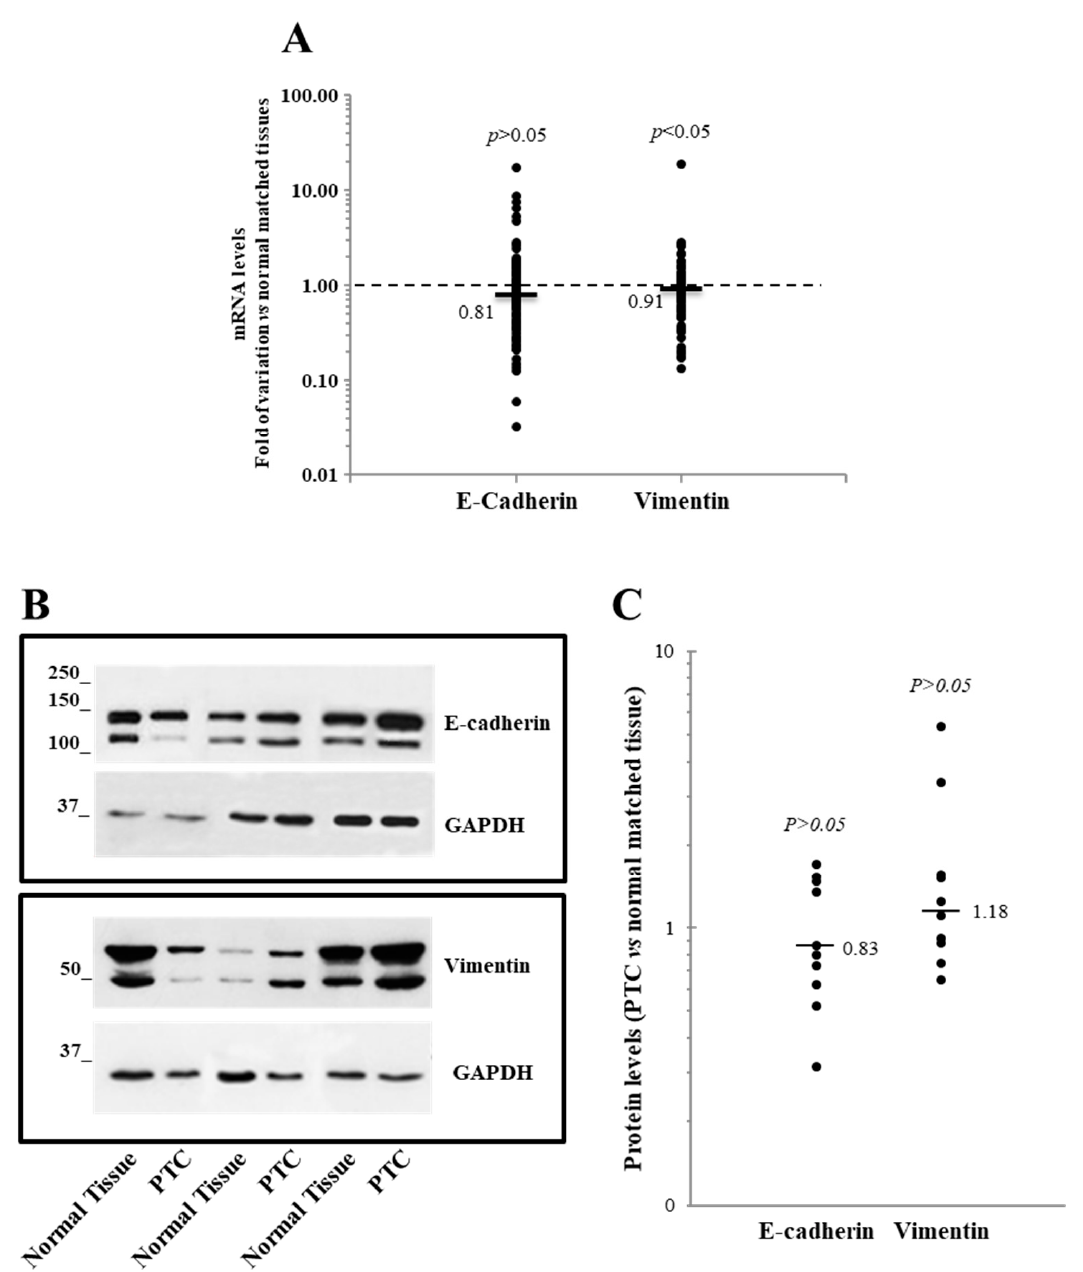
Figure 2. Expression level of the E-cadherin and vimentin in 95 papillary thyroid cancer (PTC) tissues compared with the normal matched tissues. ( A ) The E-cadherin and vimentin mRNA levels are reported. The small bars represent the median, with the values indicated. The dotted line represents the expression levels for the normal matched tissues. ( B , C ) The E-cadherin and vimentin Western blot results obtained on 10 PTC tissues and their normal counterparts. ( B ) A representative Western blot image shows three PTC, and the normal matched tissue are shown. ( C ) A densitometric analysis of the 10 PTC tissues analyzed is